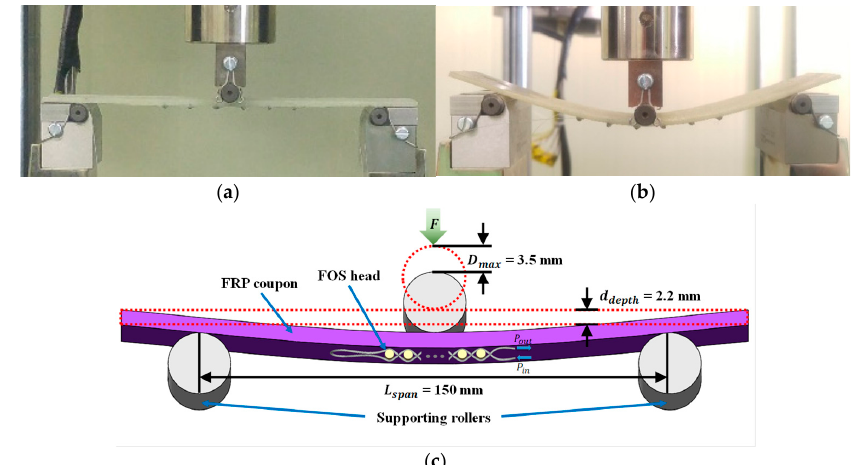
Figure 11. Three-point bending test setup with ( a ) unloaded image of the FOS head installed in the UTM; ( b ) loaded image of the FOS head installed in the UTM; ( c ) Schematic of the FOS head placement.